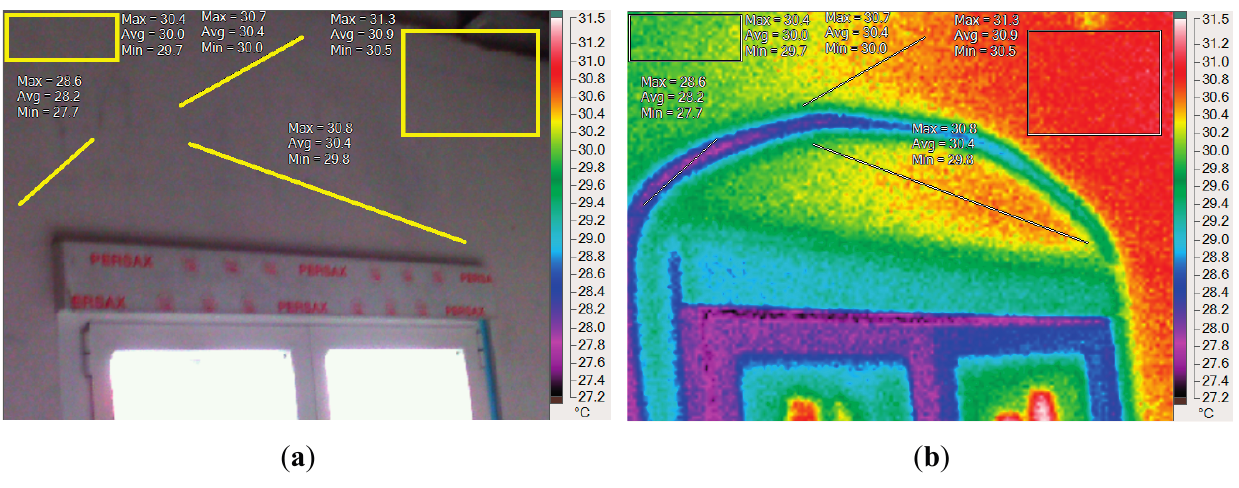
Figure 22. ( a ) Visual image of a wall and window in grey scale; ( b ) Thermal image with the fluid flowing through the wall barrier PP tubes, in false